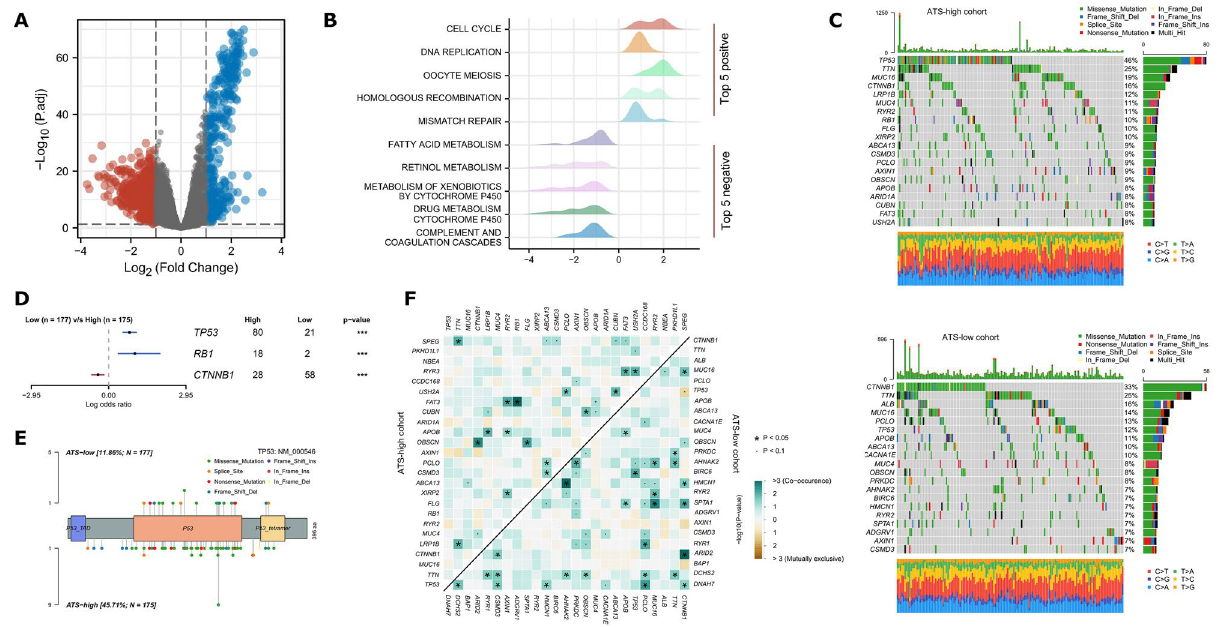
Figure 4. Comprehensive analyses of genomic alterations and biological process of ATS. ( A ) DEGs between ATS-low and ATS-high groups. ( B ) GSEA plot showing the enriched gene sets in ATS subgroups. ( C ) Mutation profiles of the top 20 most commonly mutated genes in ATS subgroups. ( D ) Prognosis effect of the differently mutated genes. ( E ) A lollipop plot demonstrating the differences in TP53 mutation locations between two cohorts. ( F ) The heatmap illustrating the co-occurrence and mutually exclusive mutations of the top frequently mutated